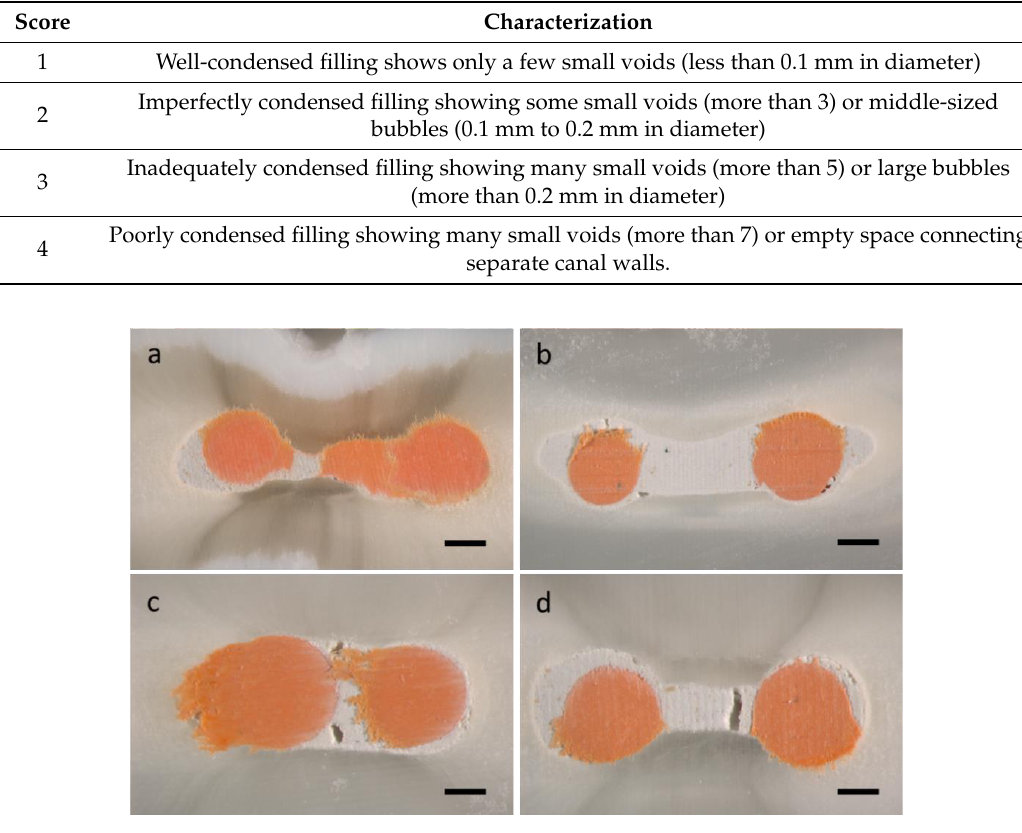
Figure 4. Representative images that were observed under a stereomicroscope: ( a ) score 1 from the WV group, ( b ) score 1 from the SU group, ( c ) score 2 from the SU group, ( d ) score 4 from the SC group. WV: warm vertical compaction, SU: single-cone technique with ultrasonic activation, SC: single-cone technique. Scale bar: 200 μm.